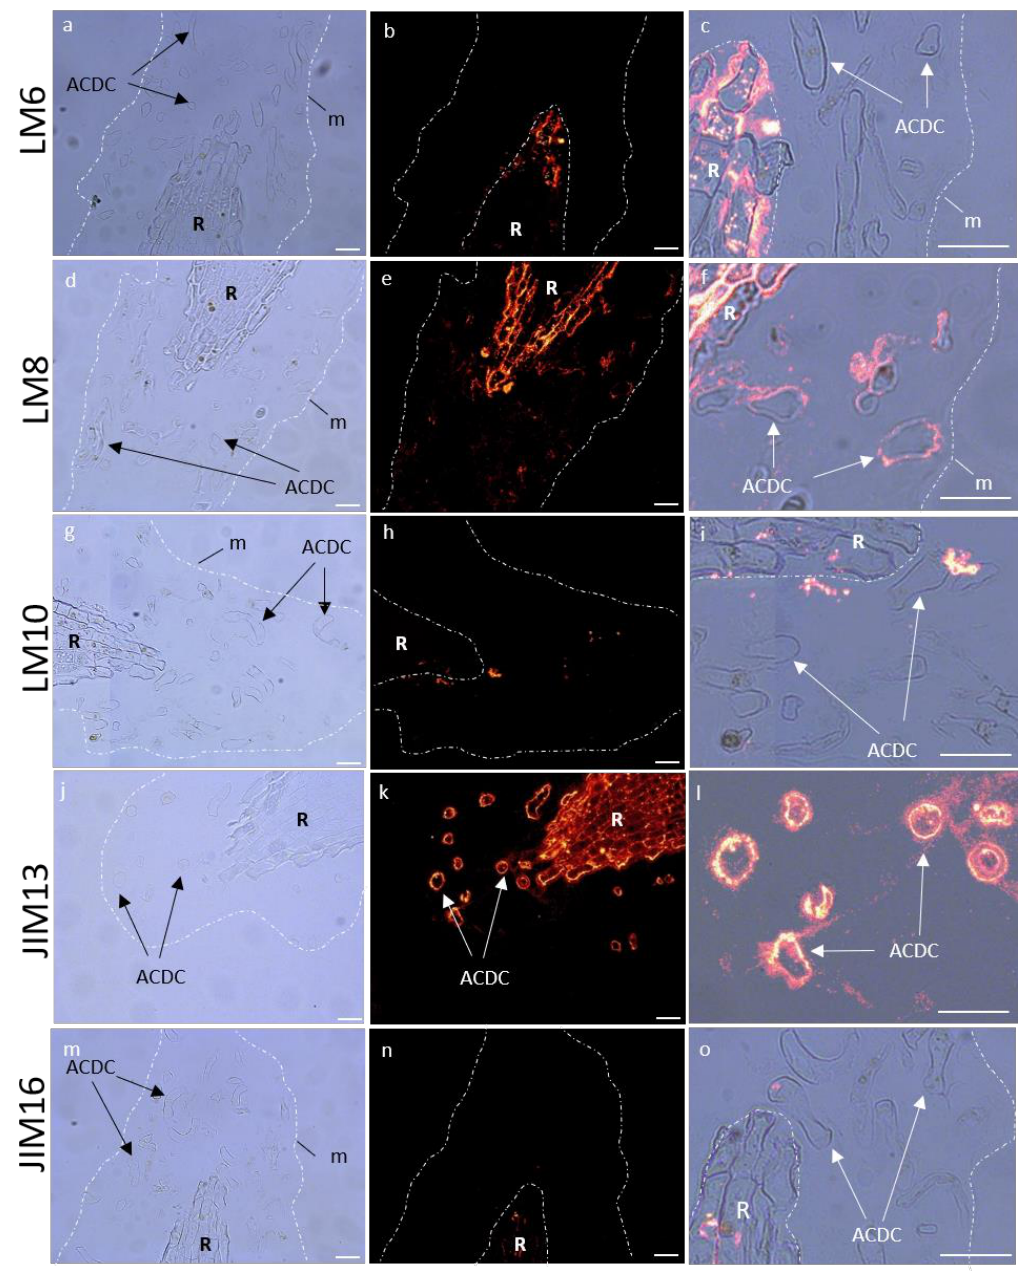
Figure 9. Immunocytochemical characterization of glycopolymers of P. nigra root extracellular trap under strong osmotic stress (PEG50). LM6 branched arabinan side chain from rhamnogalacturonan 1 ( a – c ), LM8 xylogalacturonan ( d – f ), LM10 xylan ( g – i ), JIM13 arabinogalactan protein ( j – l ), and JIM16 arabinogalactan protein ( m – o ). Left column: bright field images defining mucilage and AC-DC, central column: corresponding images with fluorescence, right column: zoom overlay of bright field/fluorescence images. The mucilage labeling of LM6, LM10, and JIM16 was not detected under osmotic stress, and lightly detected with LM8. AC-DC cell wall showed a strong labeling with JIM13. AC-DC: root associated cap derived cell, m: mucilage, R: root. Bars: 25 µm.